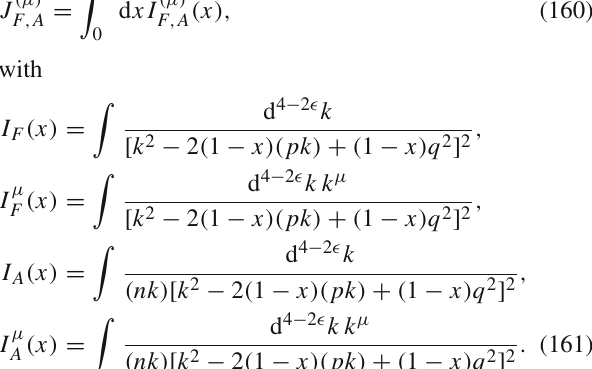
Fig. 13 One-loop quark self